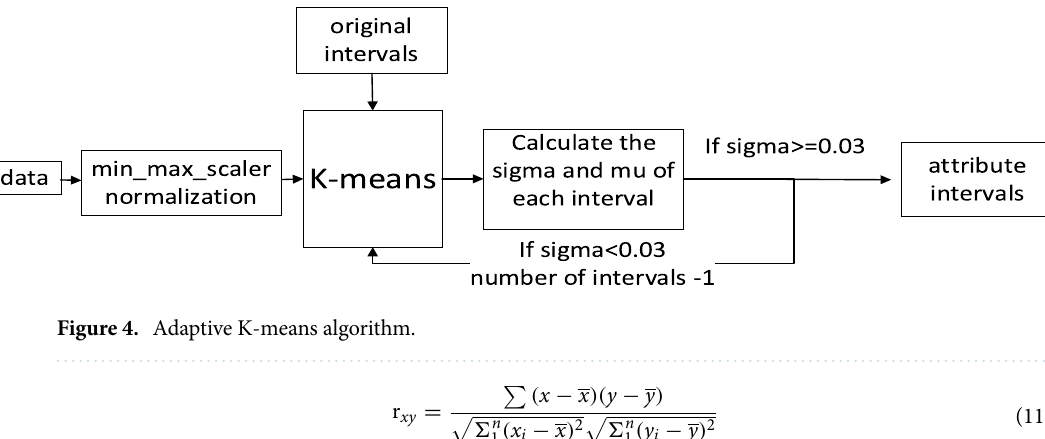
Figure 4. Adaptive K-means